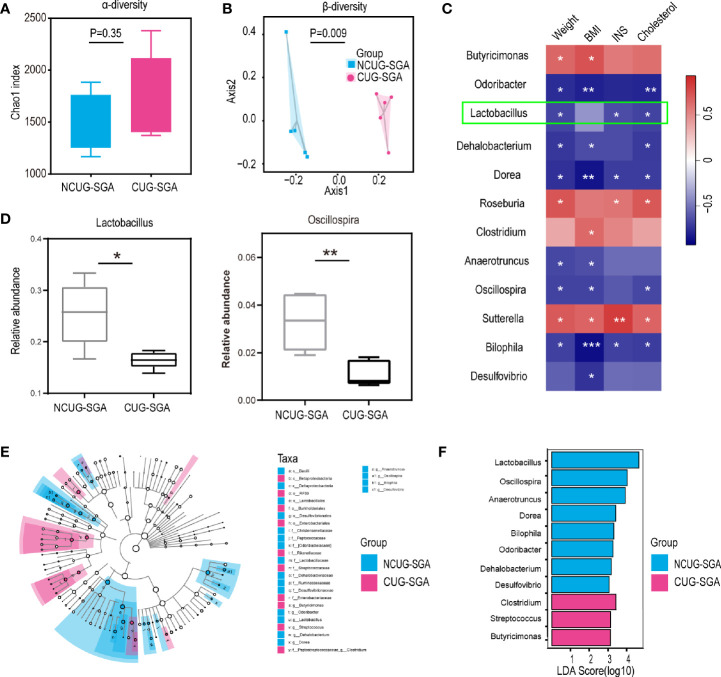
Variations in intestinal microbiota between non-catch-up growth in small for gestational age (NCUG-SGA) and catch-up growth in small for gestational age (CUG-SGA) rats (A) The α diversity of the intestinal microbiota of rats between the two groups (Chao1 index) showed that both groups have variations among individual samples within each group, but not significant difference between the two groups; (B) Comparison of the β diversity of the intestinal microbiota based on the Bray-Curtis distance shows significant difference between the NCUG- and CUG-SGA rats; (C) A heatmap of Spearman correlation between microbiota at genus level and clinical characteristics; (D) Box plots showing the abundance of Lactobacillus and Bilophila in the NCUG-SGA and CUG-SGA groups; (E) Differences of classification unit between the groups; (F) Linear discriminant analysis (LDA) effect size algorithm (LEfSe) of intestinal microbiota (LDA>3).